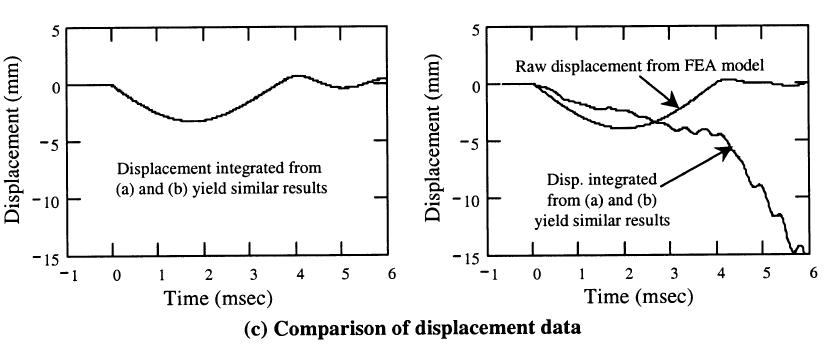
Fig. 4. Processing data without protecting against aliasing. FEA data is simply requested from solution at a 50 kHz sample